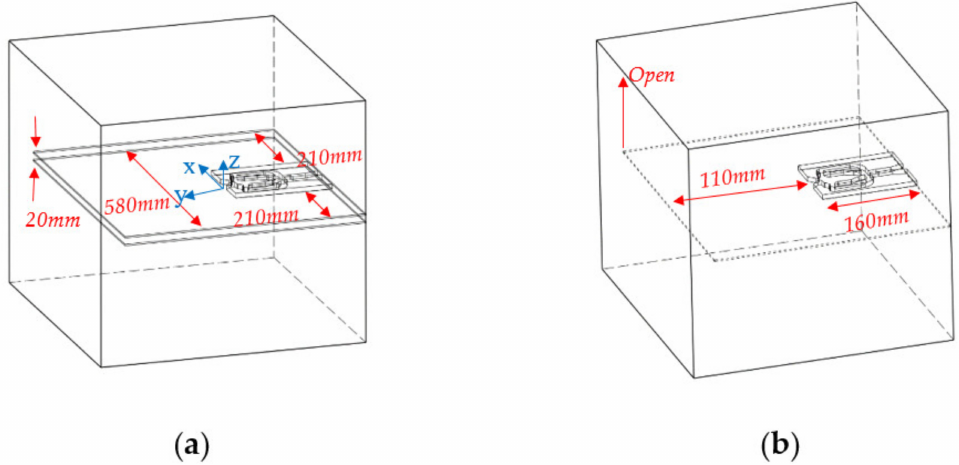
Figure 3. Diagram and size of ( a ) fully confined and ( b ) free geometry.